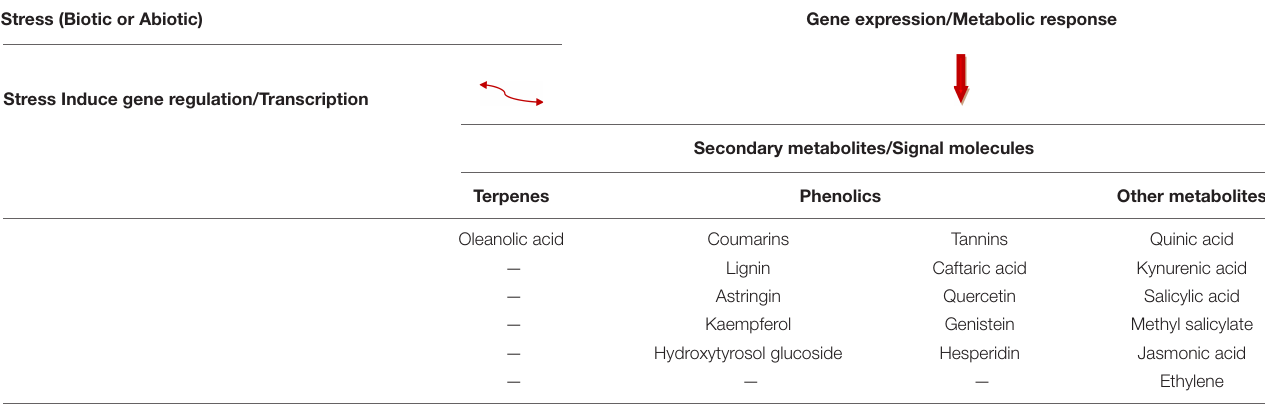
TABLE 1 | Stress induced gene regulation and expression of secondary metabolites. Stress (Biotic or Abiotic) Gene expression/Metabolic response